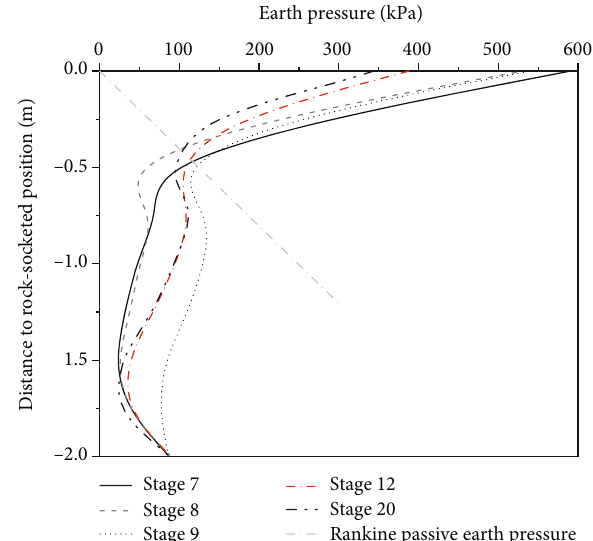
Figure 17: Earth pressure applied on the passive side of the end- suspended pile at di ff erent excavation stages.